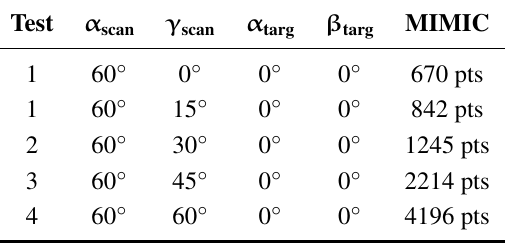
Table 4. The importance of vertical scanner rotations in a dual axis scanner orientation for a parallel 2 m × 1 m target at a horizontal range of 5 m.